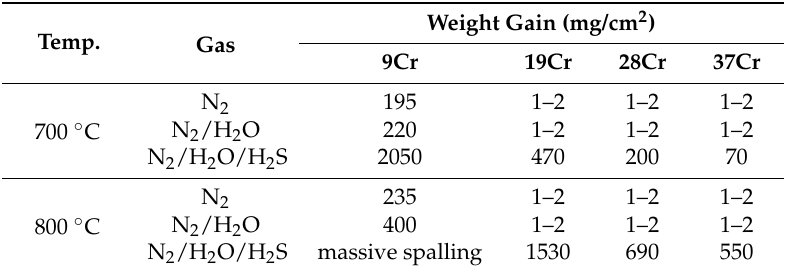
Table 1. Weight gain of Fe-(9, 19, 28, 37)Cr alloys measured after corrosion at 700 and 800 ◦ C for 70 h under 1 atm of N 2 , N 2 /3.2%H 2 O, and N 2 /3.1%H 2 O/2.42%H 2 S gas.